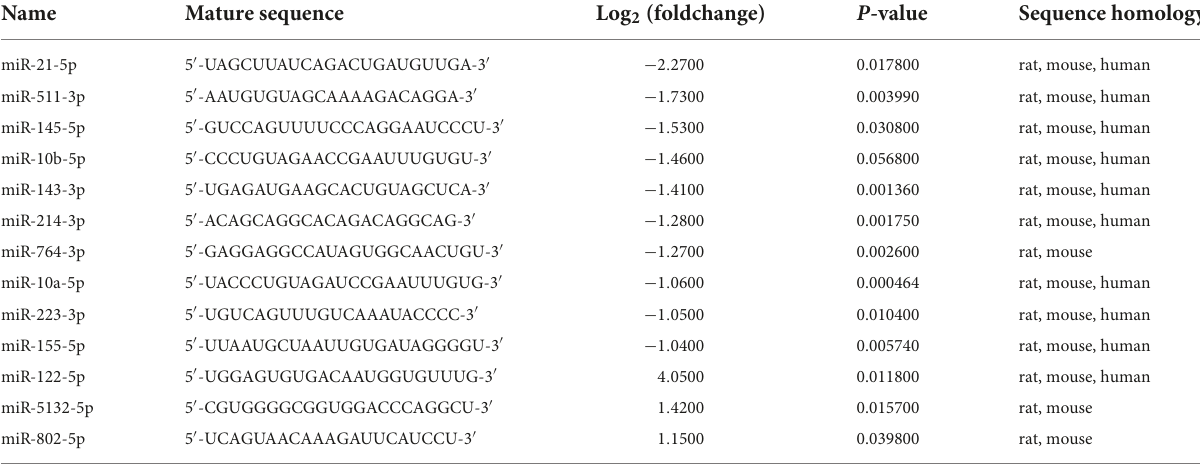
TABLE 2 Sequence and sequence homology of DEMs.